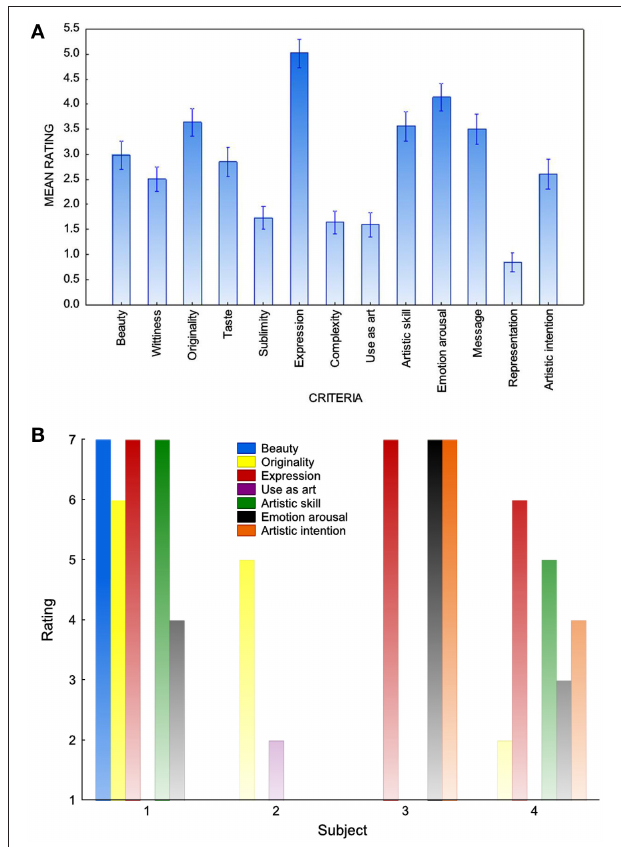
FIGURE 16 | (A) Mean values and standard errors for listeners’ ratings of criteria for aesthetic value of music. (B) Individual ratings of criteria for aesthetic value of music by four subjects (see Juslin, 2013). Reprinted with permission from Juslin (2013) © 2013